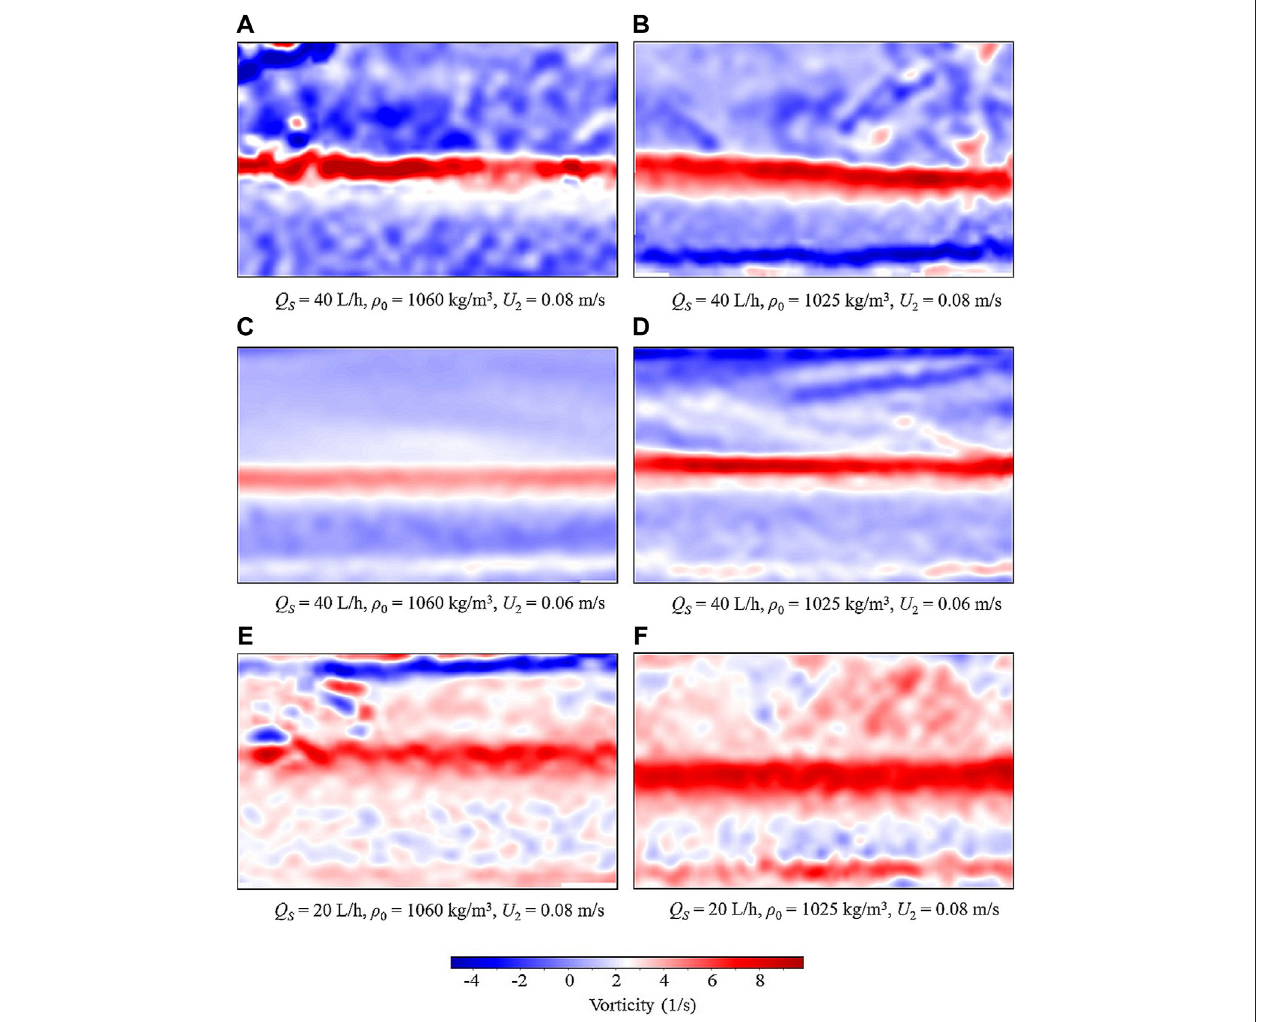
FIGURE 4 | PIV snapshots of the vorticity contours of the spanwise central plane at x = 12 z i away from the test channel inlet for (A) case 19, (B) case 15, (C) case 18, (D) case 14, (E) case 12, and (F) case 9, respectively.